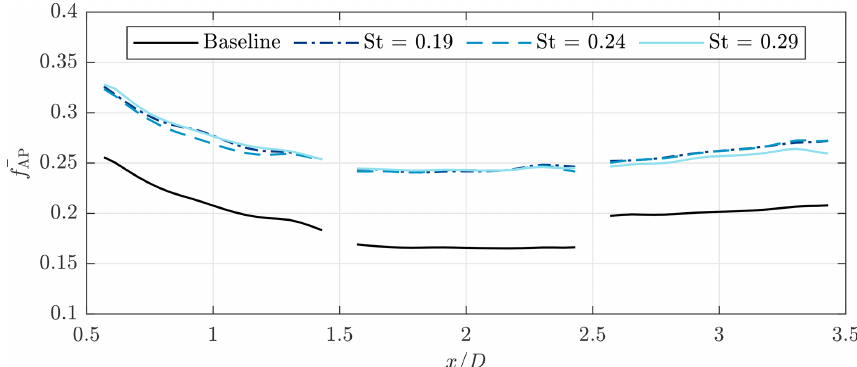
Figure 11. Average available power f AP in the wake of a turbine operated with DIC compared to baseline operation. The f AP is based on cross-sections of the measured streamwise velocity